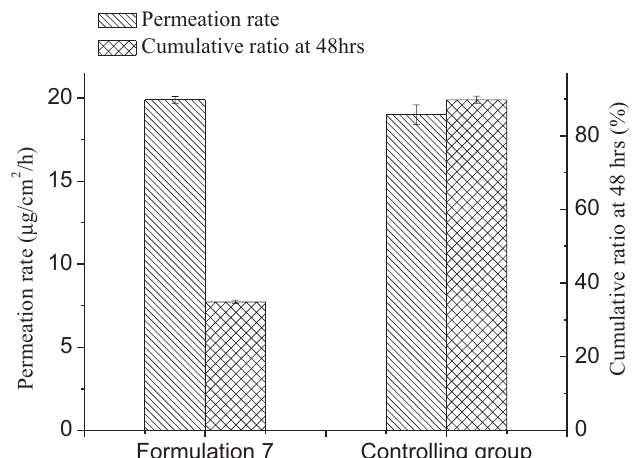
FIGURE 7 – Comparison release of the developed patch with the controlling